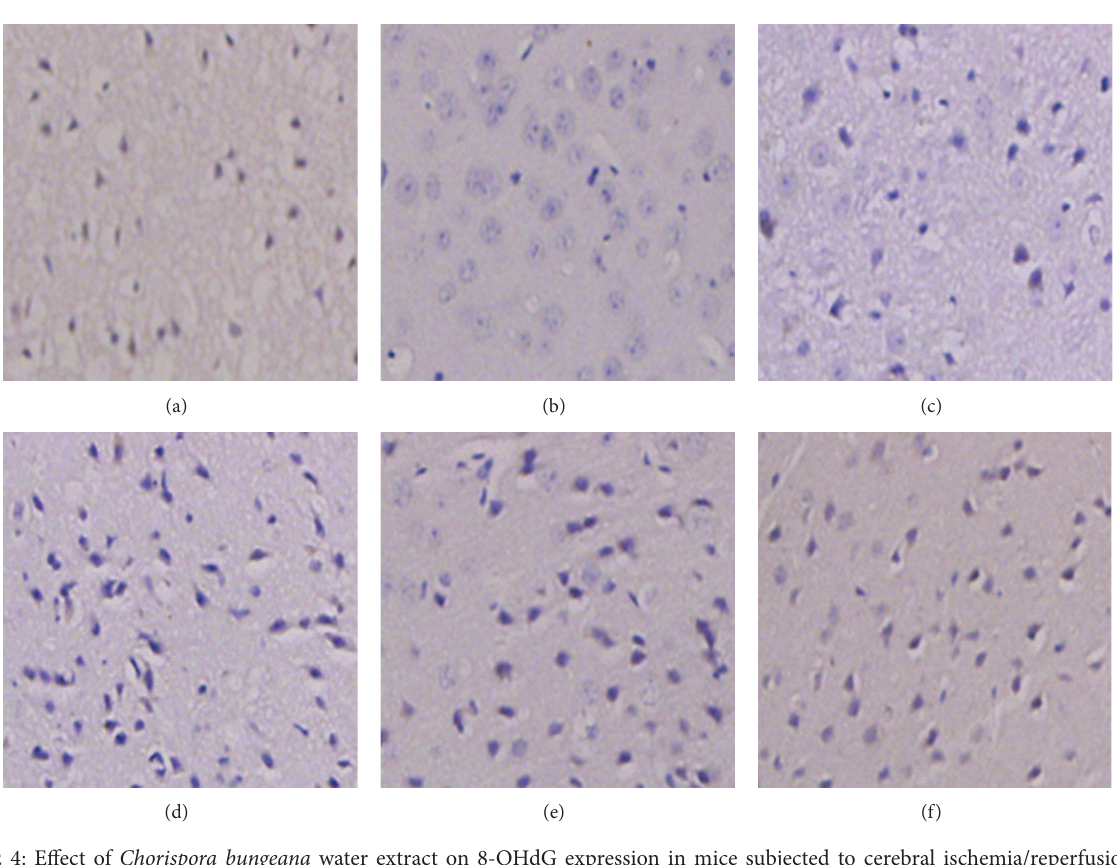
Figure 4: Effect of Chorispora bungeana water extract on 8-OHdG expression in mice subjected to cerebral ischemia/reperfusion. The nucleus of positive expressed cell is brown colored. (a) Model group; (b) Sham group; (c) Edaravone-treatment group (3mg/kg); (d) Chorispora bungeana -treatment group (5g/kg); (e) Chorispora bungeana -treatment group (2.5 g/kg); (f) Chorispora bungeana -treatment group (1.25